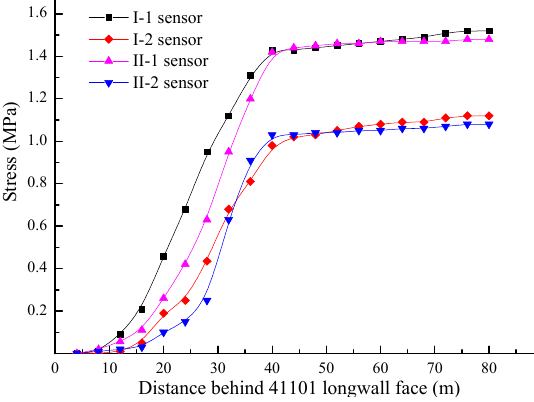
Figure 10. Thrust from rubble inside gob on filling body.